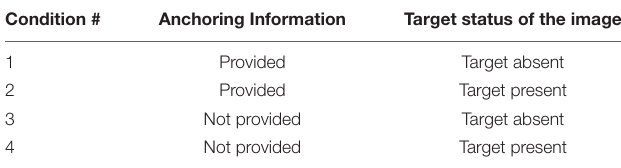
TABLE 1 | Experimental conditions in Experiment